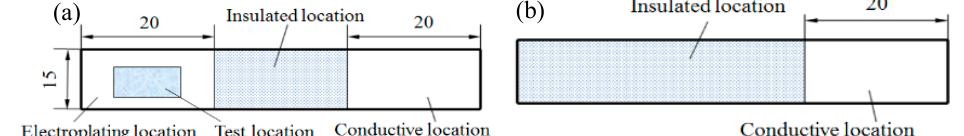
Figure 1. The 45 carbon steel substrate specification diagram: ( a ) electroplated surface, and ( b ) nonelectroplated surface.